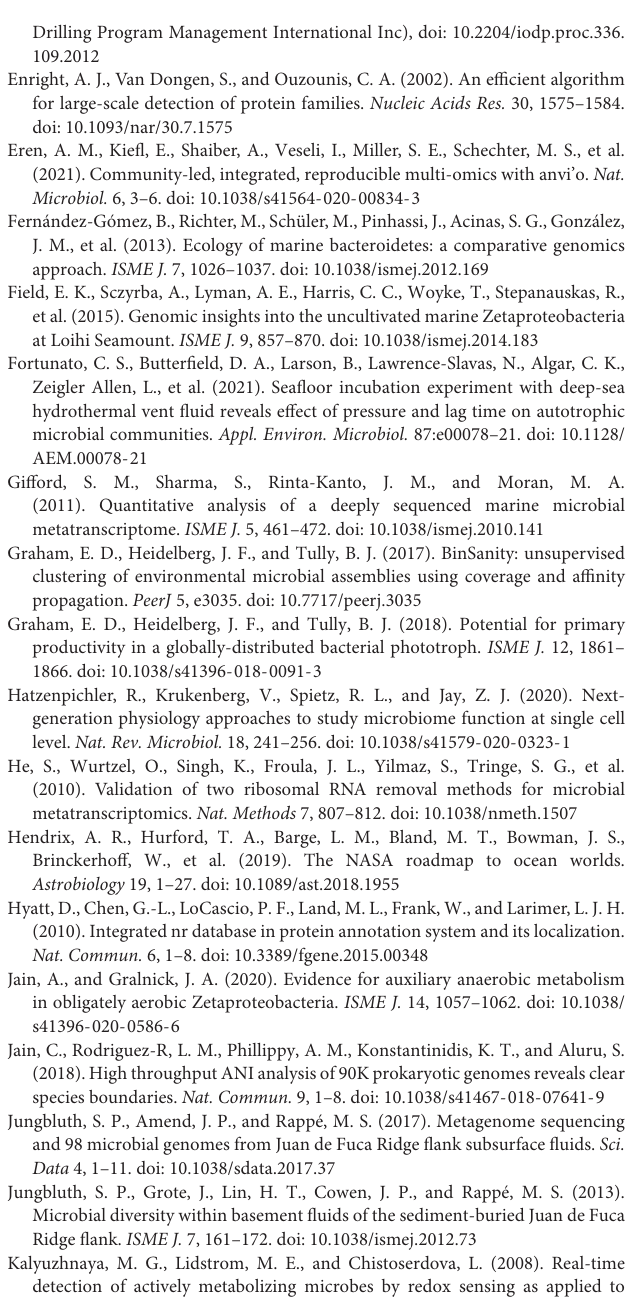
Supplementary Data Sheet 1 | SAG assembly statistics as reported by the Single Cell Genomics Center at Bigelow Laboratory for Ocean Sciences. Supplementary Data Sheet 2 | Average Nucleotide Identity (ANI) statistics for the SAG library against the Hiqh-Quality MAGs from Seyler et al. (2020). Supplementary Data Sheet 3 | DNA metagenomic read recruitment (in Reads per Thousand Million, RPKM) for individual SAGs. This analysis includes